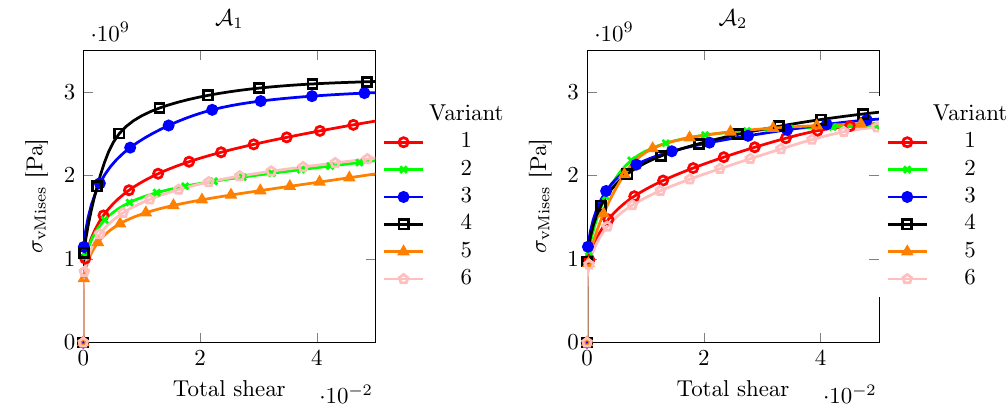
Figure 5. Directional micromechanical responses of homogeneous single crystals with the orientation of martensitic variants related to prior austenite grain subjected to the loading given in Equation